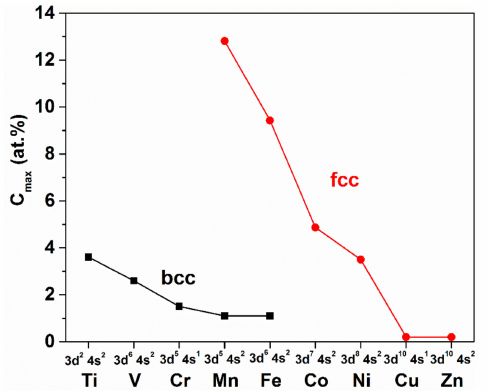
Figure 34. Maximum solubility of C in bcc and fcc allotropes of 3D transition metals together with their valence electron